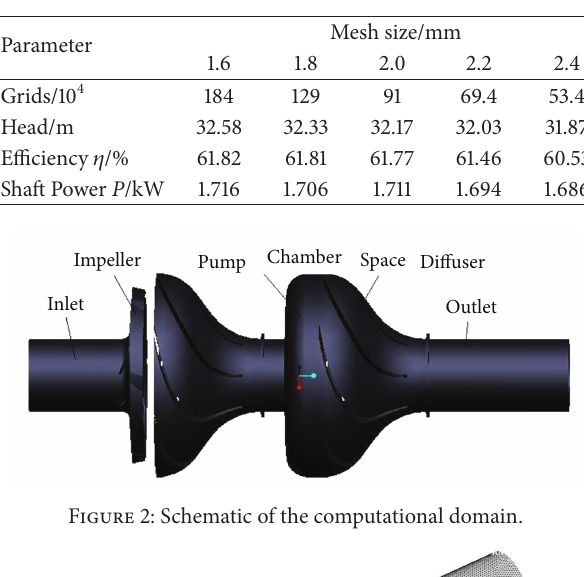
Table 7: Results of different mesh sizes.